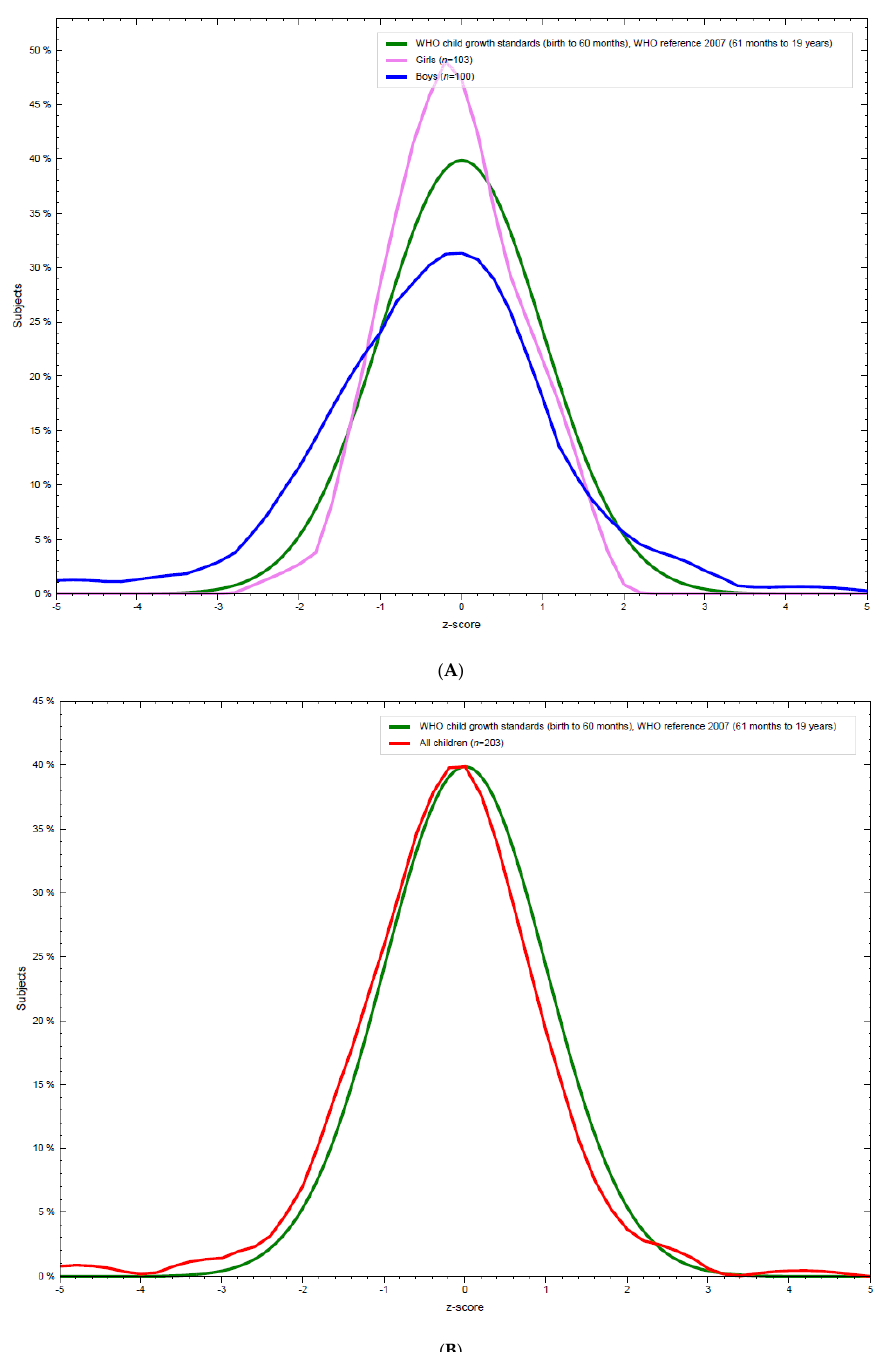
Figure 1. ( A ) BMI-for-age distribution of adolescent, boys and girls Afghan refugees. ( B ) Distribution of BMI-for-age of all the adolescents as compared to the WHO standard. However, combined BFA distribution for all participants does not show major devi- ation from the normal curve (Figure 1B). One in three adolescents also showed stunted growth with highest prevalence in young adolescent age 10 – 14 years (Table 2). No statistically significant difference was observed be- tween height-for-age z-score (HAZ) for boys and girls. HAZ distribution of all the participants showed significant deviation from the WHO growth standard curve (Figure 2A); the distribu- tion of which is shifted to the left with low mean HAZ. HAZ distribution for both sexes are shown separately in Figure 2B. Both showed significant deviation from the WHO growth standard with higher stunting observed in boys as compared to girls.